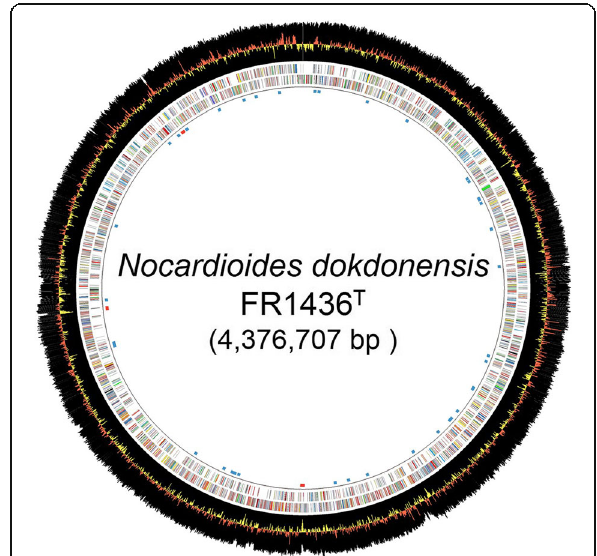
Fig. 3 Circular representation of the genome of N. dokdonensis FR1436. The first and second circles from inside indicate COG-assigned genes in color codes. Black circle represents the G + C content and red-yellow circle is for the G + C skew. Innermost, blue-scattered spots are tRNA genes and red-scattered spots indicate rRNA